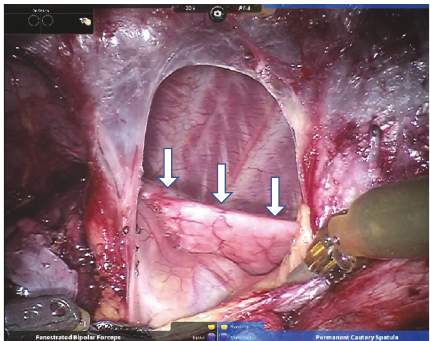
Figure 1: Restriction of left (dependent) lung expansion including the upper lobe of the left lung (arrow) during the inspiratory phase after an incision of the left mediastinal